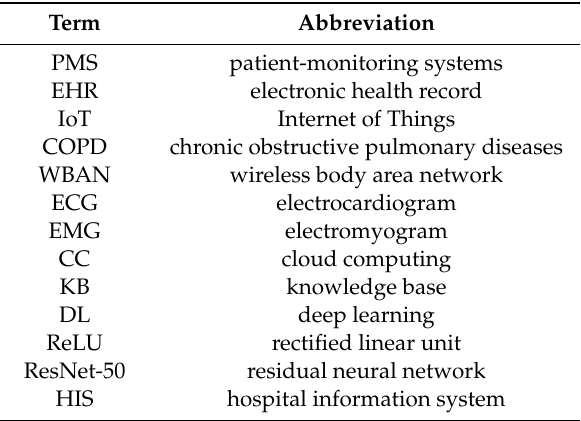
Table A2. List of